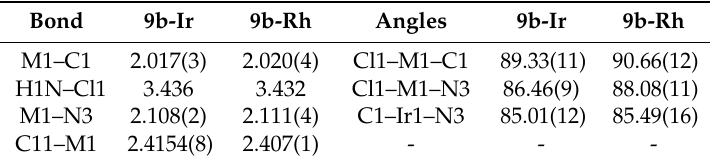
Table 1. Selected bond distances (Å) and angles ( ◦ ) in the cations of 9b-Ir and 9b-Rh .